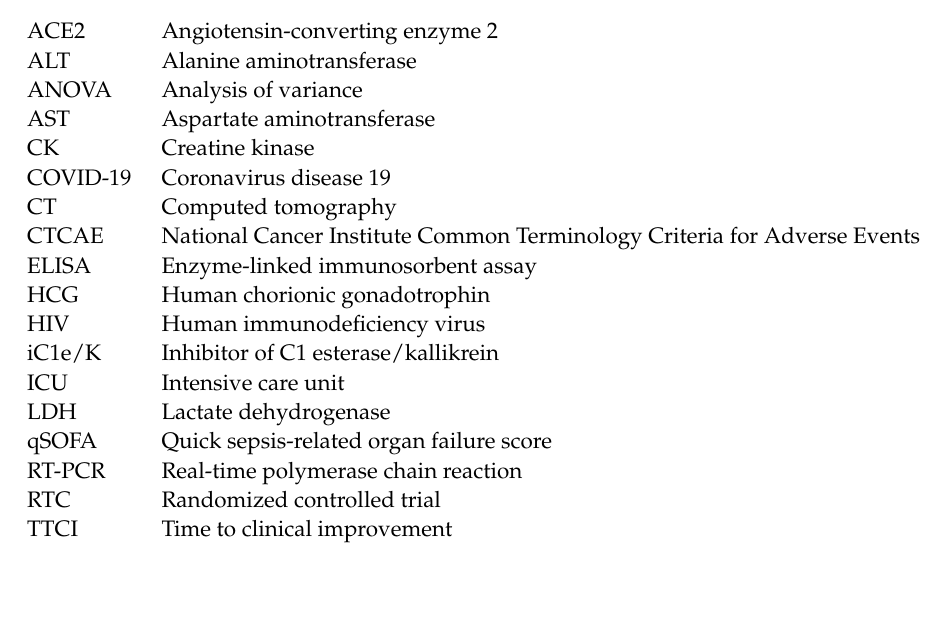
study; Table S3: Supporting medication; Table S4: Blood cell counts; Table S5: Blood coagulation parameter values; Table S6: Parameters related to renal function; Table S7: Adverse effects during intervention; Table S8: Clinical variables at discharge; Supplementary Figure S1: Computed tomog- raphy lung scans obtained from patients randomized to standard care; Supplementary Figure S2: Computed tomography lung scans obtained from patients randomized to icatibant; Supplementary Figure S3: Computed tomography lung scans obtained from patients randomized to inhibitor of C1 esterase/kallikrein